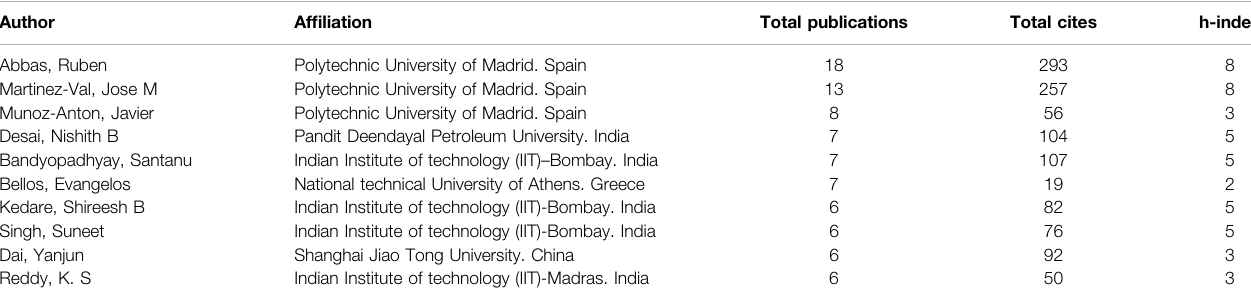
TABLE 17 | Top 10 authors in the Fresnel fi eld.